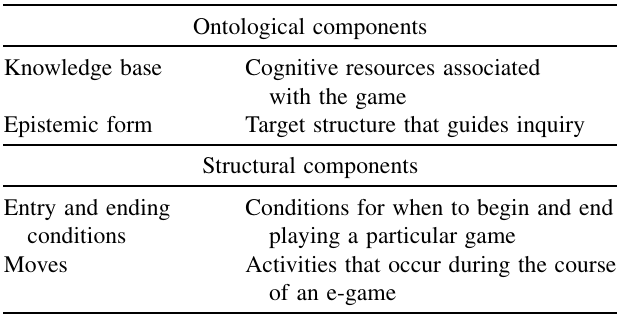
TABLE I. The ontological and structural components of epis- temic games. (Reproduced from Tuminaro and Redish